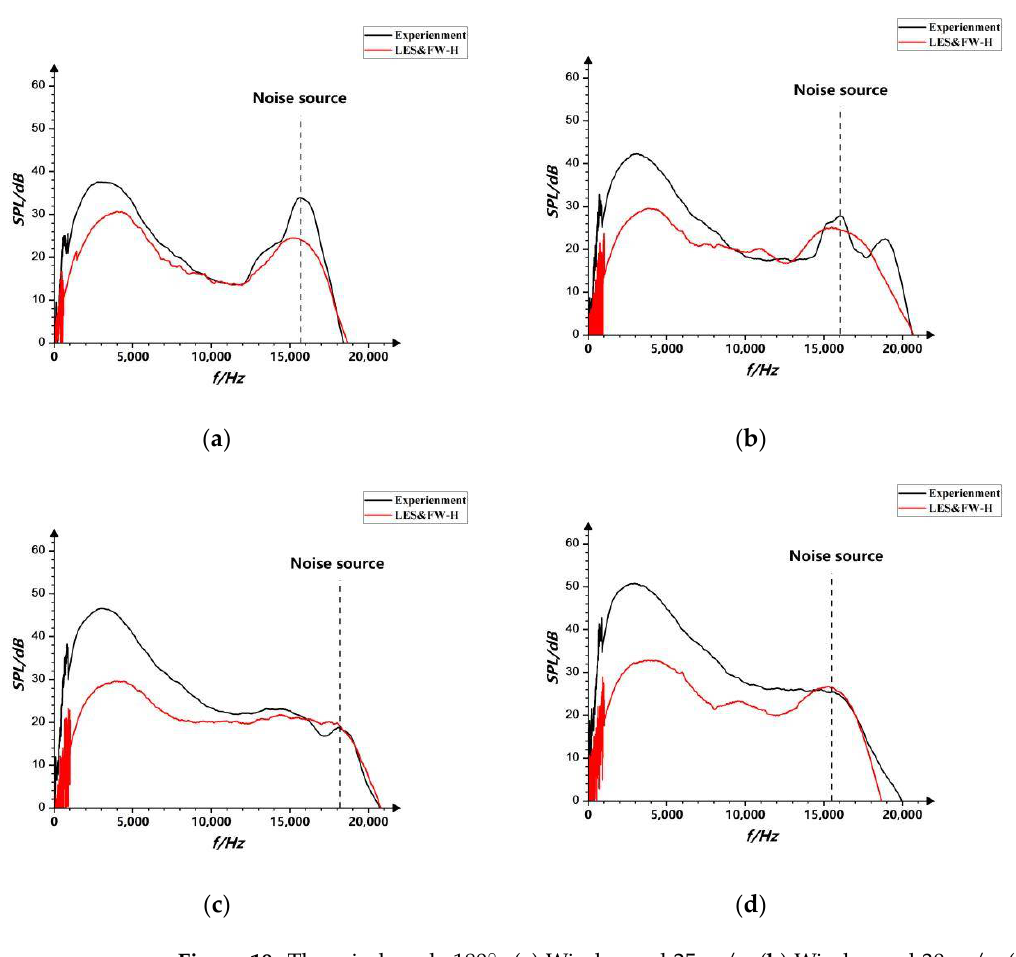
Figure 19. The wind angle 180°. ( a ) Wind speed 25 m/s; ( b ) Wind speed 30 m/s; ( c ) Wind speed 35 m/s; ( d ) Wind speed 40 m/s.